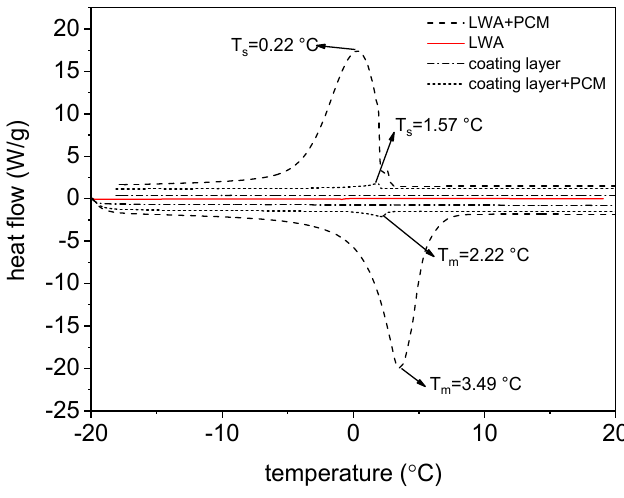
Figure 7. Thermal analysis tests of ME-LWA, the raw LWA and the resin coating.